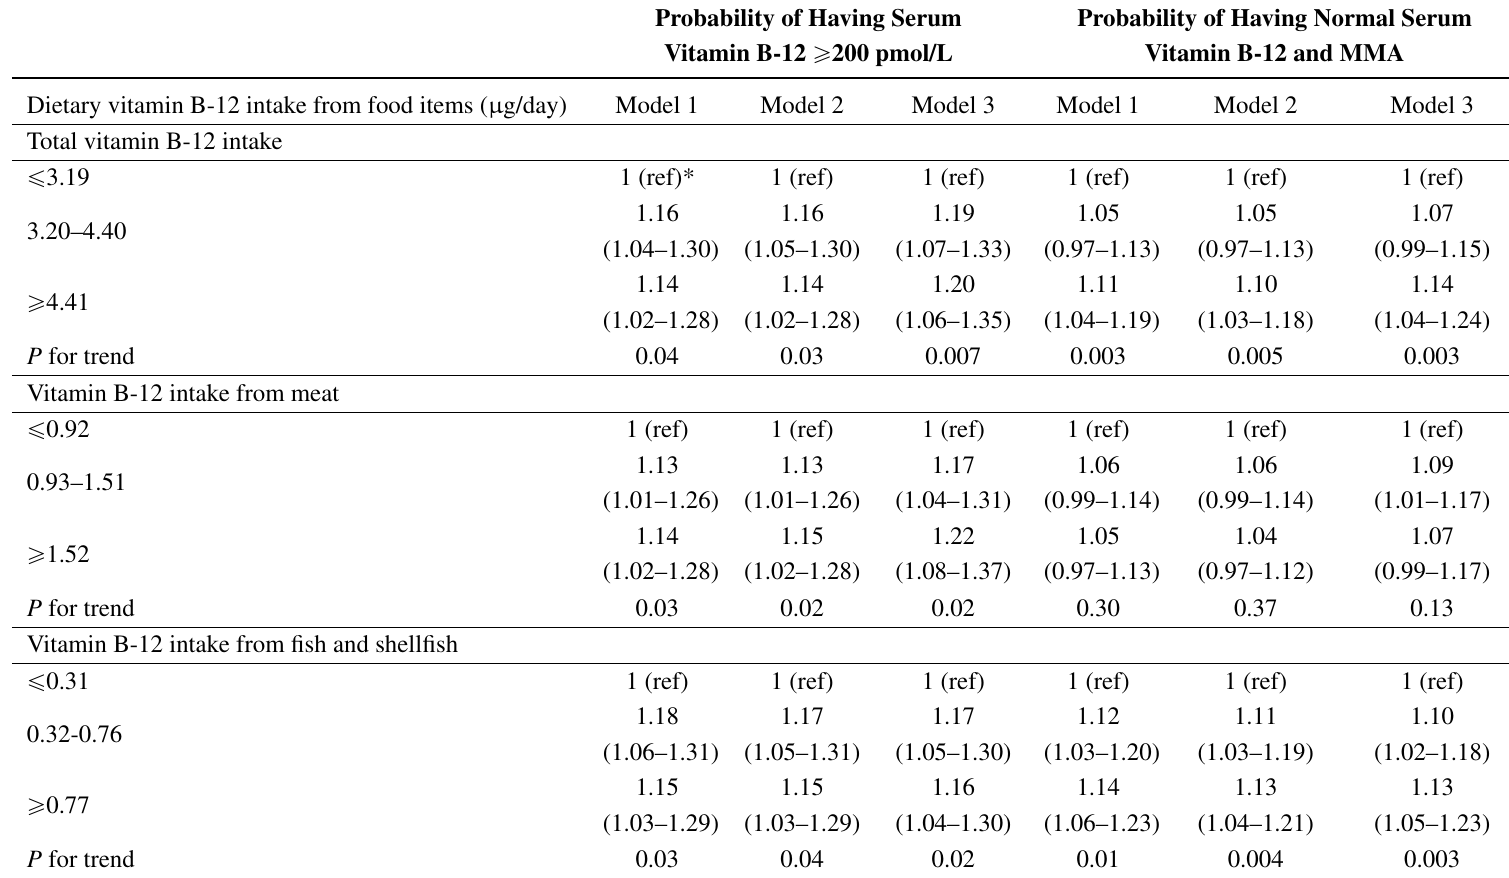
Table 4. Prevalence ratios and 95% CIs of participants with serum vitamin B-12-concentations ě 200 pmol/L vs <200 pmol/L or normal serum vitamin B-12 and MMA vs. impaired serum vitamin B-12 and MMA (vitamin B-12 < 200 pmol/L and methylmalonic acid >0.27 µ mol/L) by tertiles of vitamin B-12 intake from different dietary